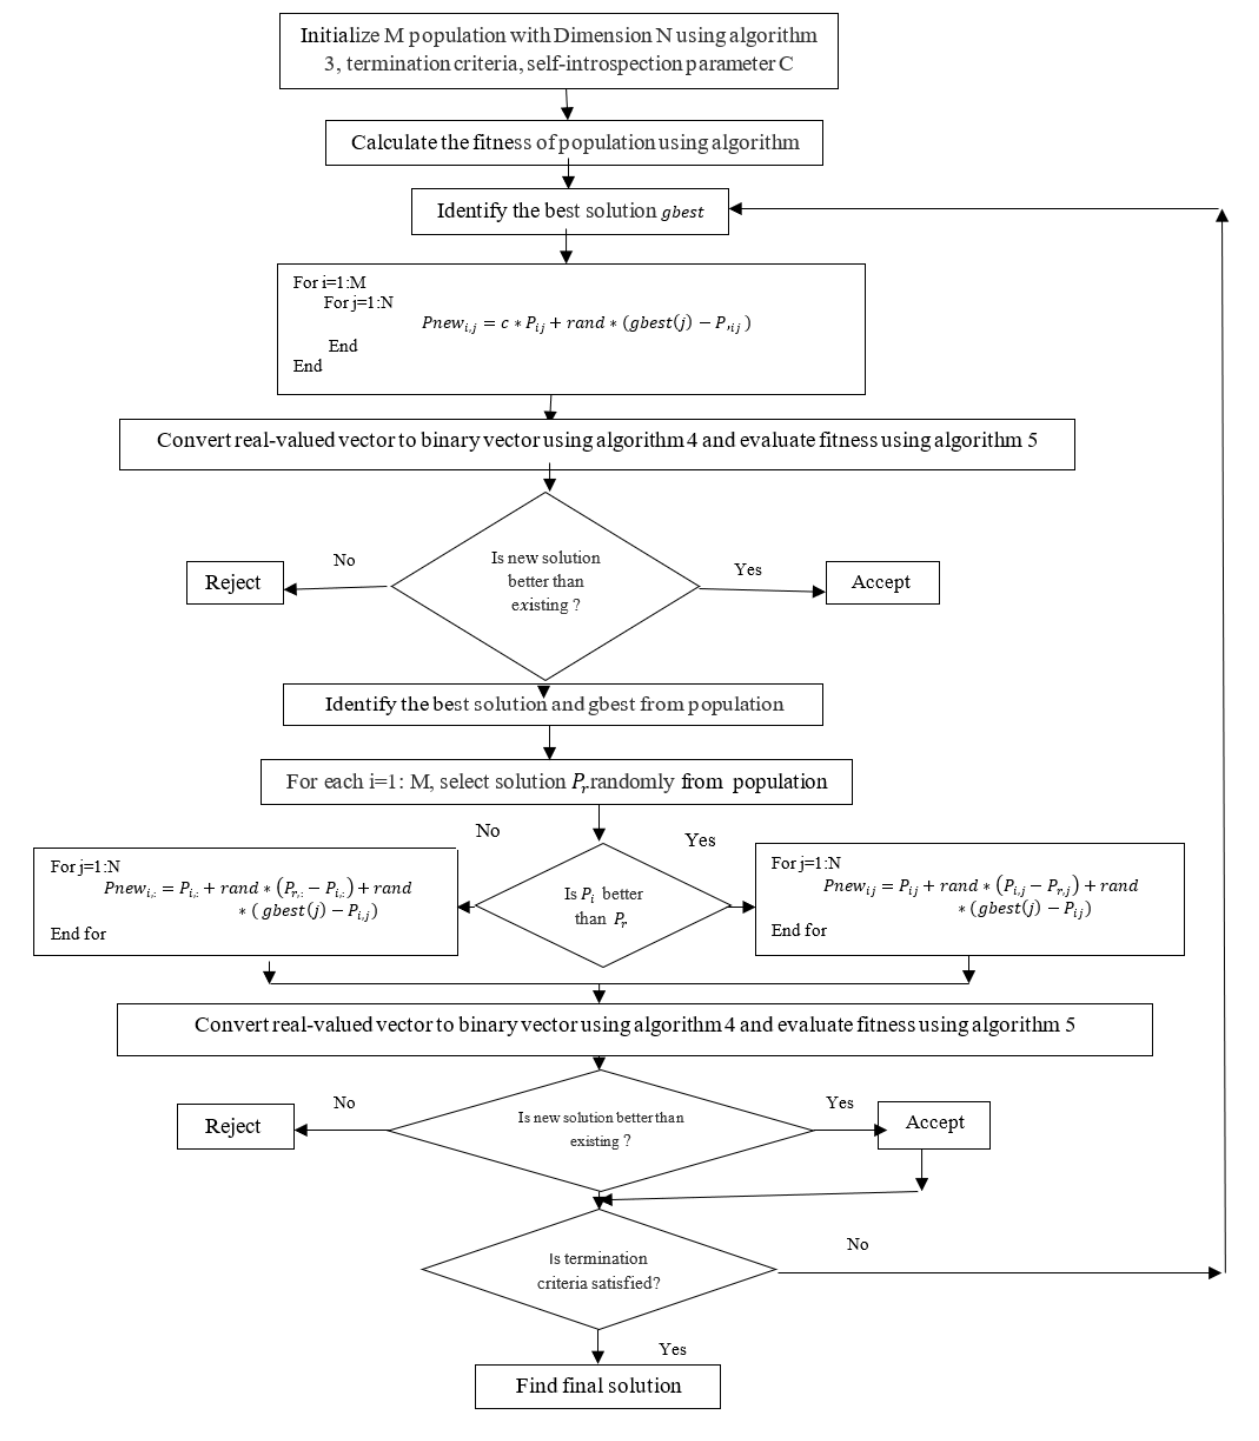
Fig. 1. Framework of BSGO